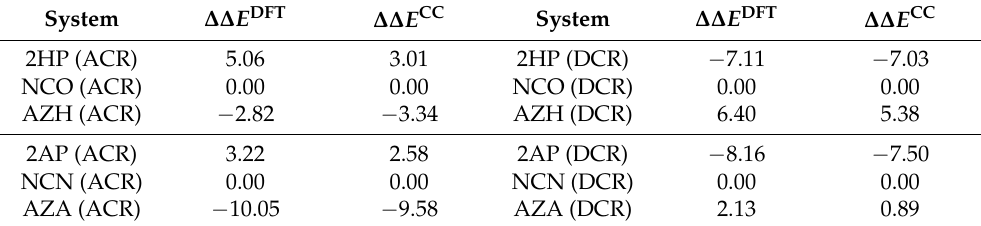
Table 1. Values of ∆∆ E , as defined in Equation (3), computed in the DFT and CC approximations described in the main text. NCO and NCN denote formamide and formamidine, respectively, the reference systems shown in Figure 2c. All values are reported in kcal/mol.